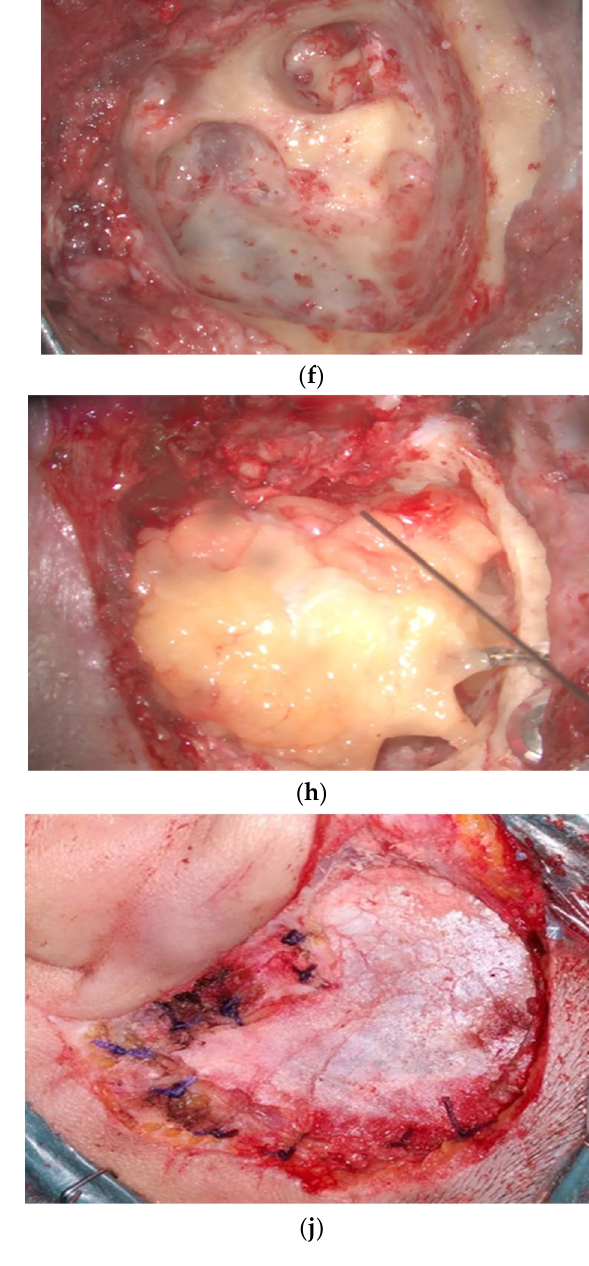
Figure 1. Subtotal petrosectomy. ( a ) Wide retroauricular incision with 360° sectioning of EAC. ( b ) Blind sac closure of EAC. ( c ) Second layer closure with tragal cartilage. ( d ) Musculoperiosteal incision U-shaped pedicle superiorly. ( e ) Musculoperiosteal flap reflected superiorly. ( f ) Elimination of temporal bone cells as required. ( g ) Placement of the implant and insertion of electrode array. ( h ) Fat is used to obliterate the cavity. ( i ) Musculoperiosteal flap repositioned. ( j ) Tight closure of periosteal flap.